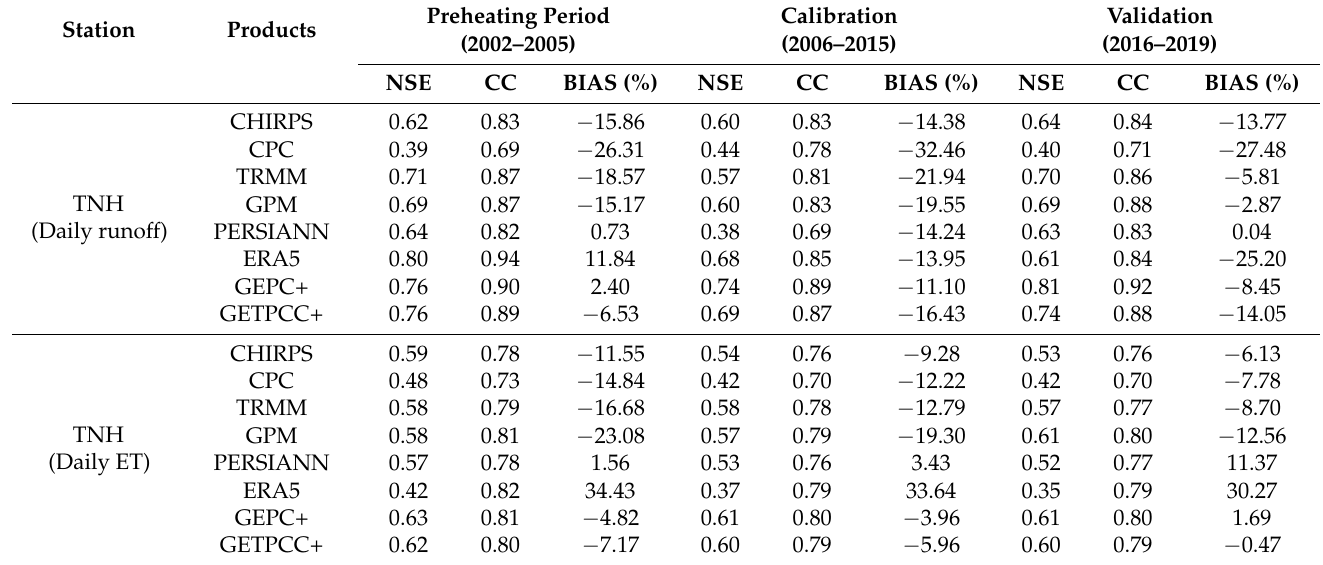
Table 3. Evaluation of VIC simulated runoff and evapotranspiration drove by eight precipitation